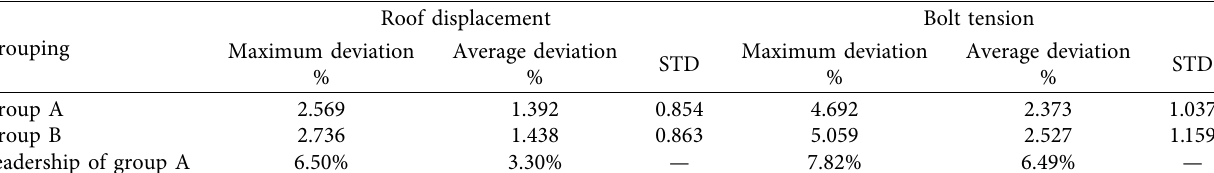
Figure 4: Modeling scheme of two-step bench method heading face (side Table 1: Comparison of overall statistical results (data source: collected by the study).